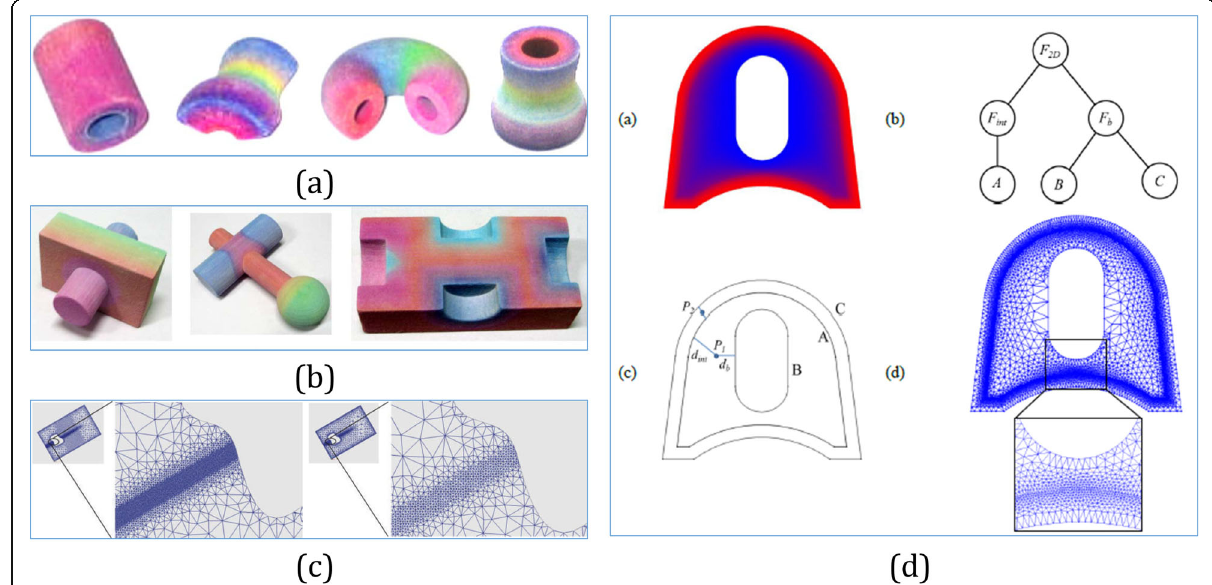
Fig. 4 a Prototypes fabricated with a hierarchical representation for unidirectional material gradient [45]. b Prototypes fabricated with non- manifold heterogeneous cells [46]. c Adaptive meshing results of 2D heterogeneous objects using material quadtree based on different thresholds [47]. d Heterogeneous feature tree structure processes objects with complex material gradient functions